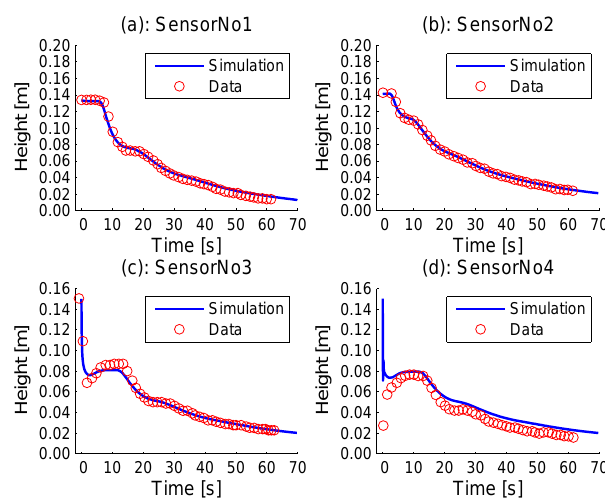
Fig. 9. Comparison of simulated water depth and measured depth of the dam break experiment for the first four sensors at the upstream